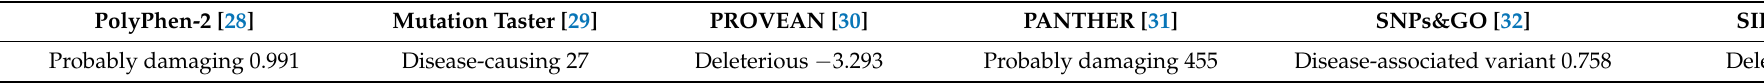
Table 2. Overview of different prediction tools analyzing DES